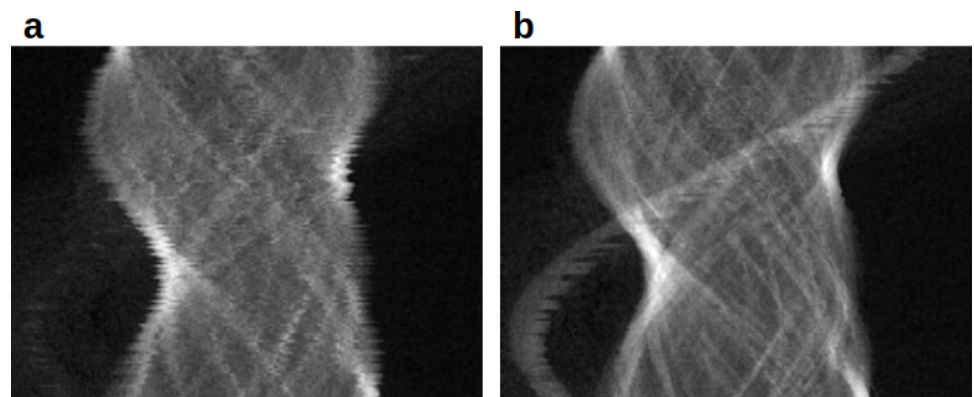
Figure 7. A real µ-CT dataset is artificially deteriorated by randomly shifting the projection in x , y . In the misaligned dataset ( a ), the faint trace of an off-axis feature becomes evident with the post-acquisition alignment (panel ( b